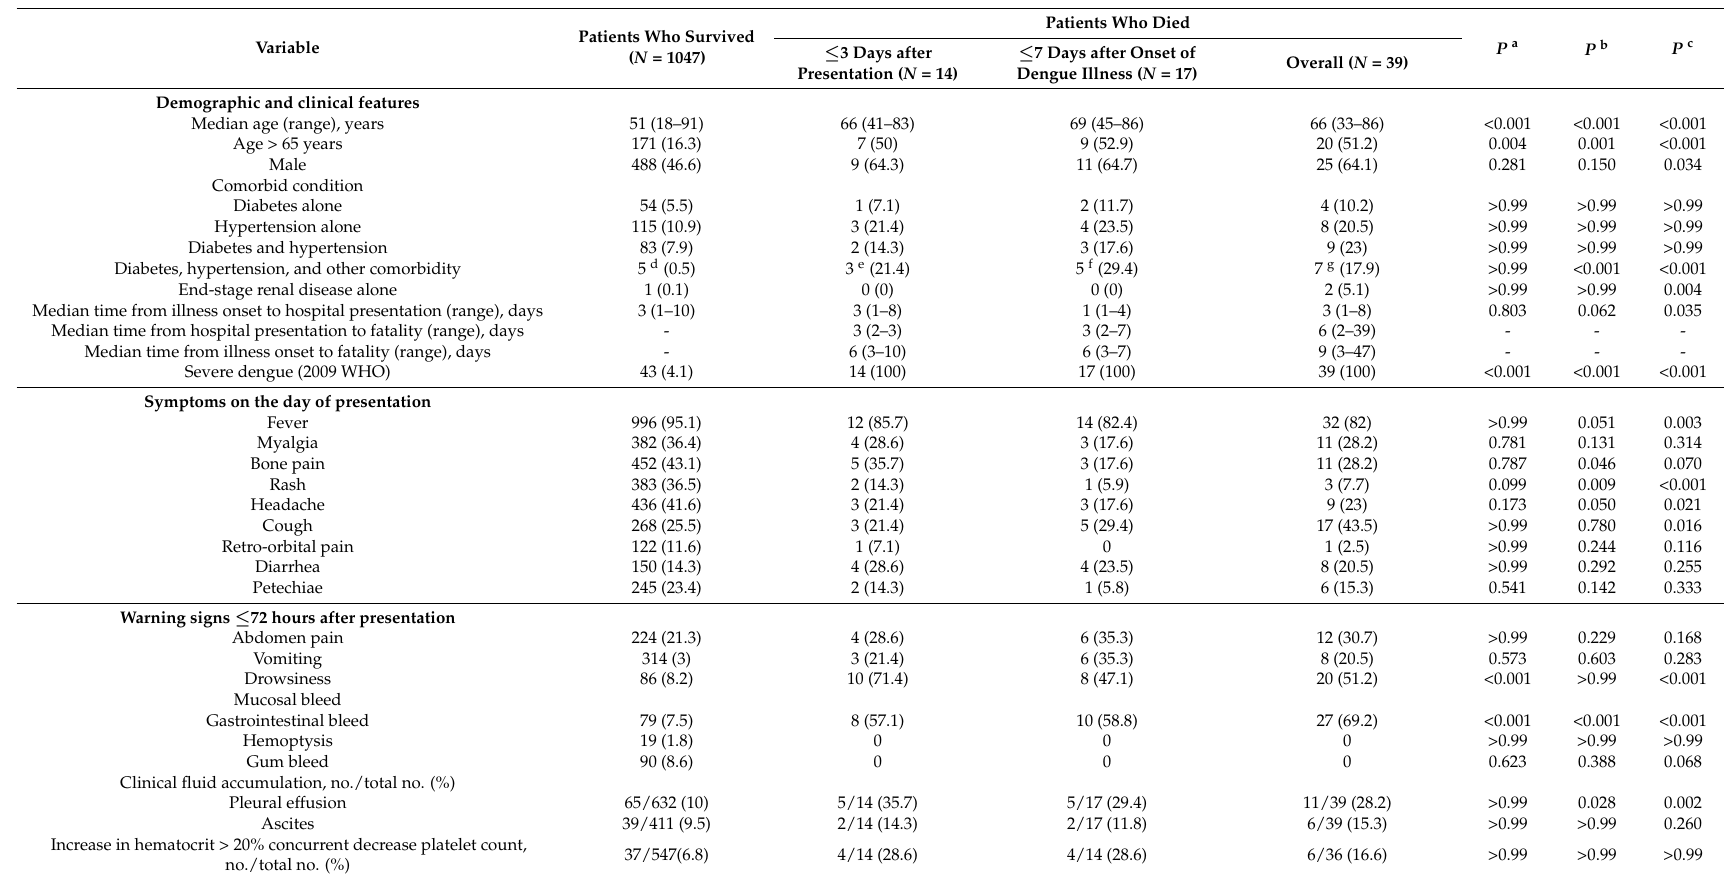
Table 2. Comparison of clinical and laboratory characteristics between survivors and